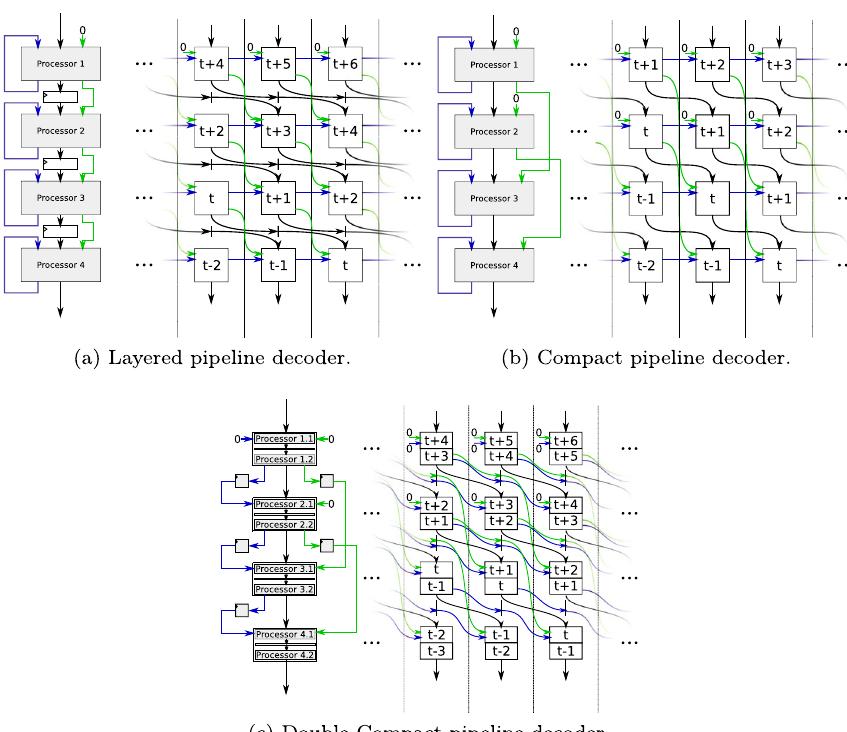
Fig. 5 Pipeline decoder architectures and pipeline